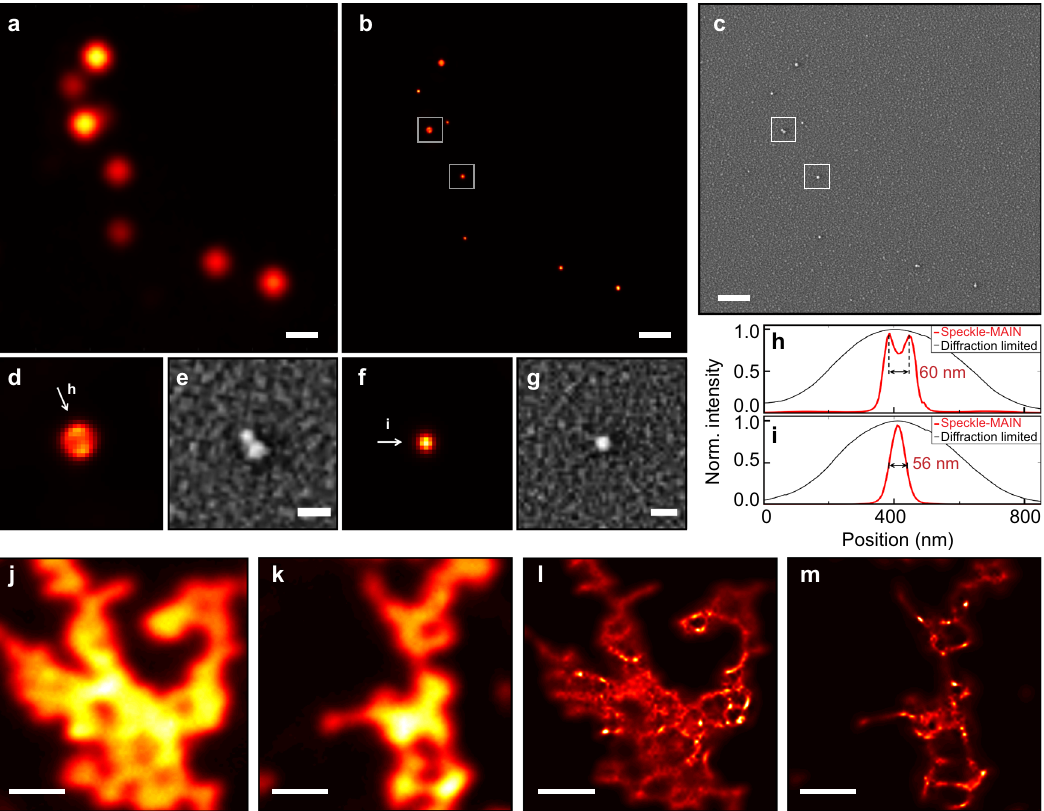
Fig. 4 Speckle-MAIN super-resolution image of fl uorescent beads and Qdot 605. a Diffraction-limited image of fl uorescent beads. b Reconstructed speckle-MAIN image. c SEM image. Scale bar: 600 nm. d – g zoomed-in images ( b ) and ( c ) of fl uorescent beads. Scale bar: 100 nm. h, i Normalized intensity cross-section (red curves) of images ( d , f ) along indicated direction. Black curves show the corresponding intensity cross-section of conventional wide- fi eld images. j , k Diffraction-limited image. Objective lens: 50×/0.8 NA. l , m Reconstructed speckle-MAIN image of Qdot 605. Scale bar: 2 μ m. Exposure time: 200 ms, frame rate: 1 fps.